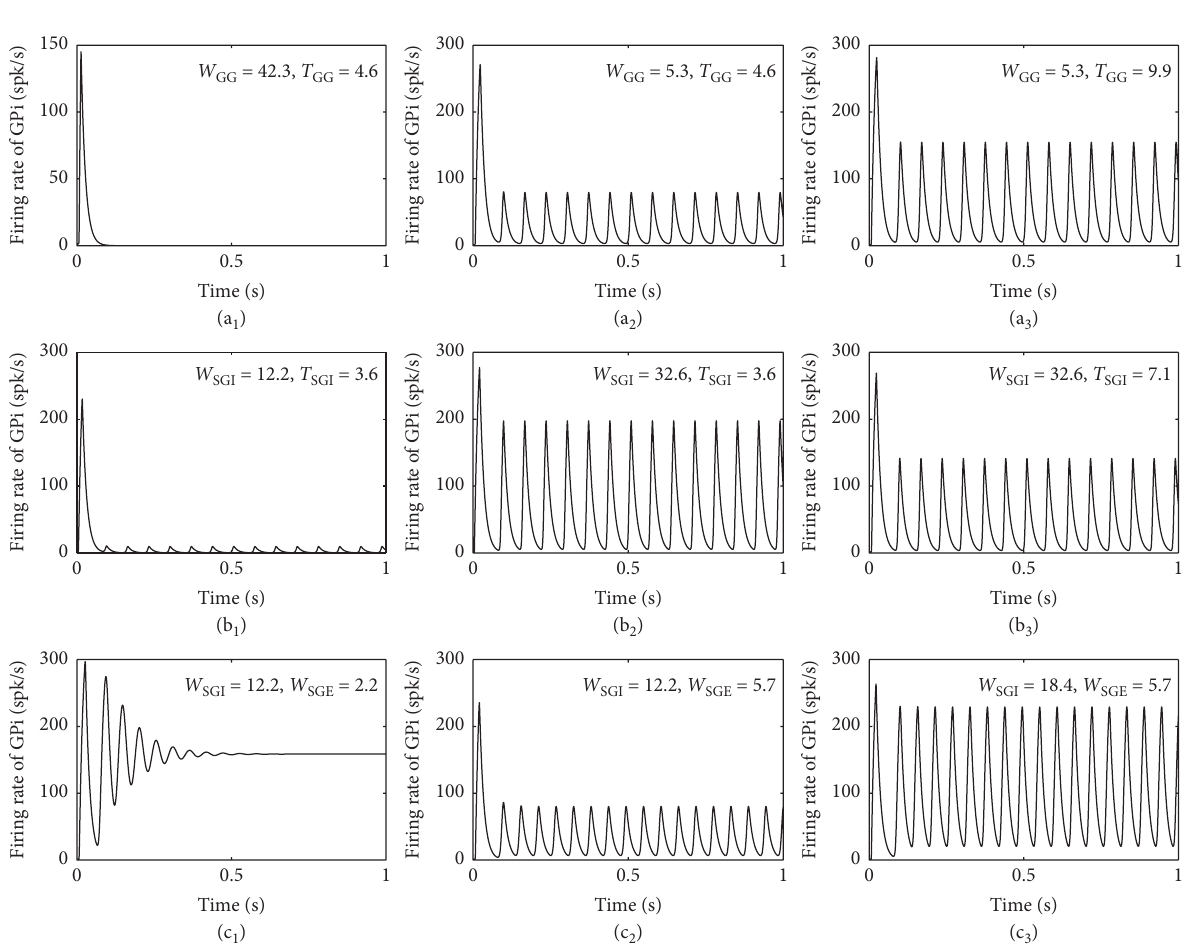
W − T , (b 1 )–(b 3 ) W 1 )–(a 3 ) GG GG